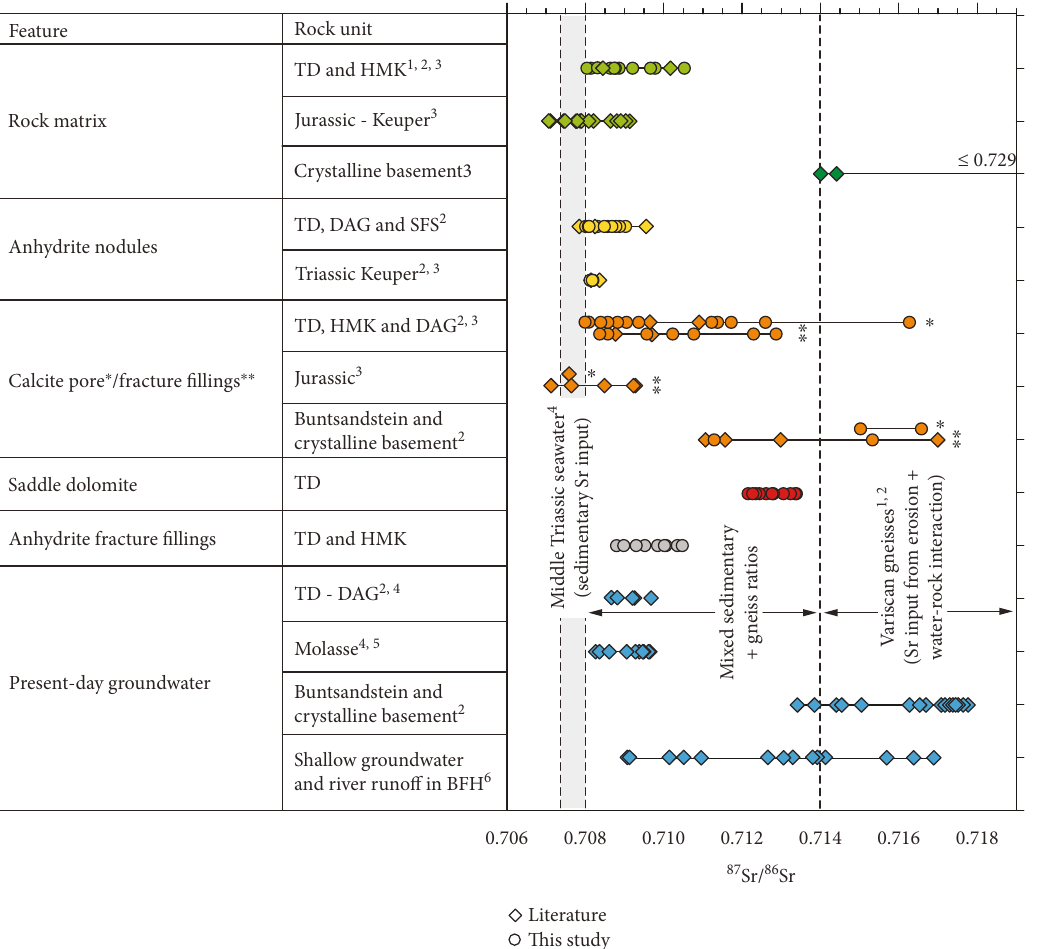
Figure 8: Strontium isotope ratios of minerals, rocks, and recent groundwater in the Upper Muschelkalk and in overlying and underlying units (TD: Trigonodus Dolomit; HMK: Hauptmuschelkalk; DAG: Dolomit der Anhydritgruppe; SFS: Sulfatschichten; BFH: Black Forest Highlands; 1 [37], 2 [20], 3 [38], 4 [39], 5 [21], 6